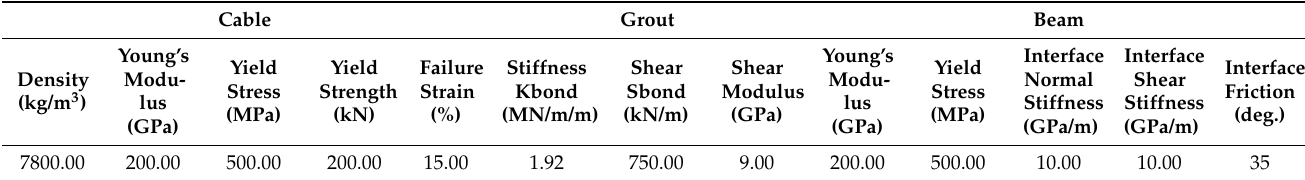
Table 3. Properties of support elements used in the BBM model.